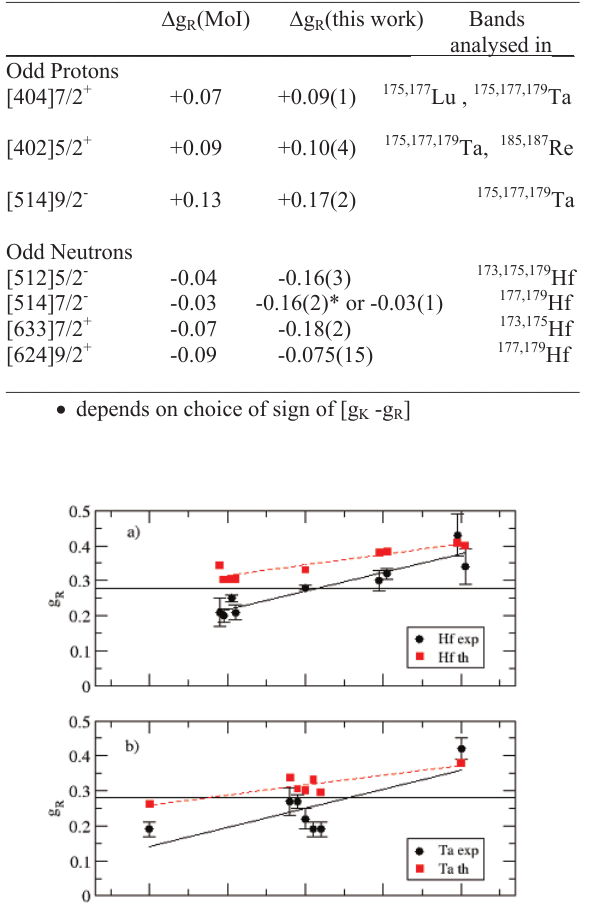
Table 3. Comparison between changes in g R , estimated from Eqs. 7, 8 and [7] (column 2) and experiment (this work) for single quasi-particle bands. Values of g R(e and W [0.275(4)].